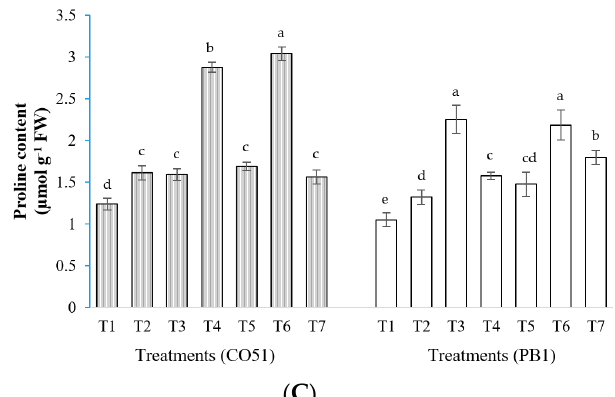
Figure 3. Effect of inoculation of halotolerant endophytes and rhizobacteria on photosynthetic pigments and compatible solute accumulation. ( A ) Chlorophyll content, ( B ) Carotene content, and ( C ) Proline accumulation in two rice varieties, CO51 and PB1. T1 = Negative control, T2 = Positive control (200 mM NaCl), T3 = 200 mM NaCl + Trichoderma viride , T4 = 200 mM NaCl + Bacillus haynesii 2P2, T5 = 200 mM NaCl + Bacillus safensis BTL5, T6 = 200 mM NaCl + Brevibacterium frigoritolerans W19, and T7 = 200 mM NaCl + Pseudomonas fluorescens. The treatment data with the same letters within the same cultivar are statistically non-significant at p ≤ 0.05. Means are separated by Duncan’s multiple range test. Error bars indicate standard deviation.